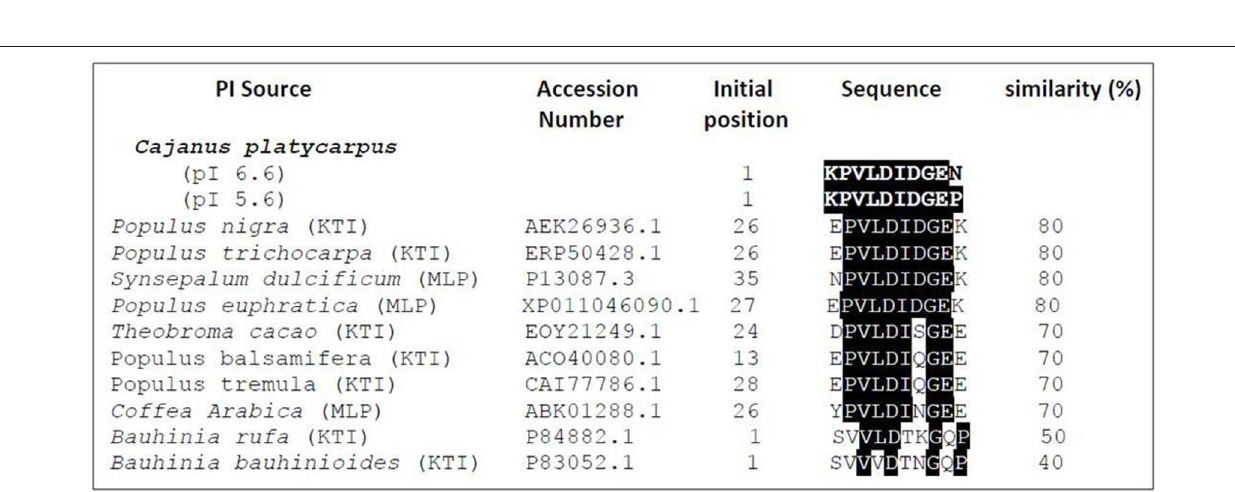
FIGURE 3 | Alignment of N-terminal sequences of isoinhibitor spots of CpPI 63. The isoinhibitor spots with pI 6.6 (KPVLDIDGEN) and pI 5.6 (KPVLDIDGEP) separated in 2-D gel under reducing conditions showed homology with other known Kunitz-type trypsin inhibitors from P. nigra (Nr: AEK26936.1); P. trichocarpa (Nr: ERP50428.1); T. cacao (Nr: EOY21249.1); P. balsamifera (Nr: ERP50428.1 ); P. tremula (Nr: CAI77773.1); B. rufa (Nr: P84882.1); B. bauhinioides (Nr: P83052.1) as well as miraculin-like proteins from S. dulcificum (Nr: P13087.3); C. arabica (Nr: ABK01288.1); P. euphratica (Nr: XP_011046090.1). The search criterion was limited with “Non-redundant protein sequences” and Plants (Taxid: